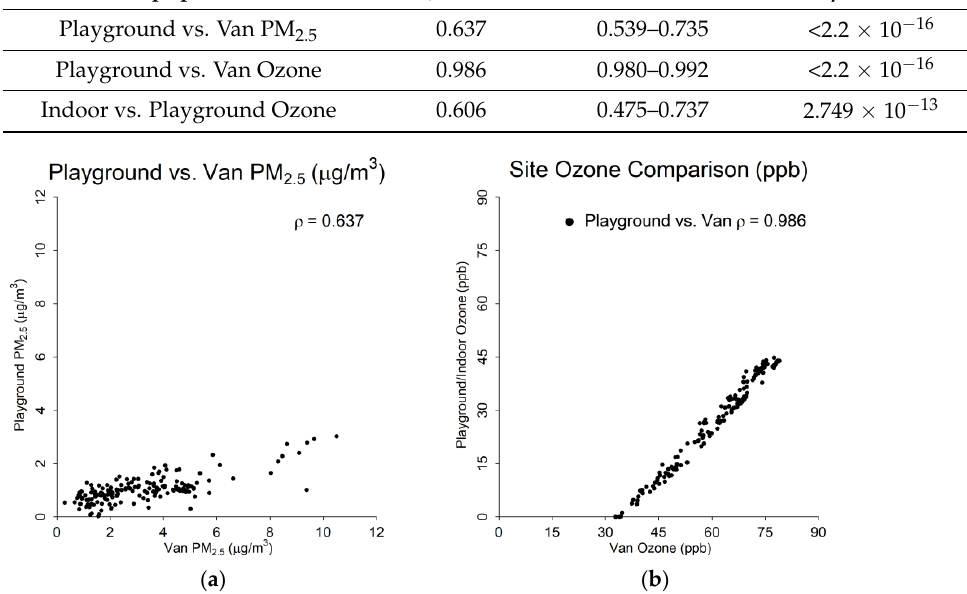
Figure 11. Site pollutant readings comparisons for Bonneville Phase 2 campaign (13–27 February 2020) for ( a ) fine particulate matter and ( b ) ozone.